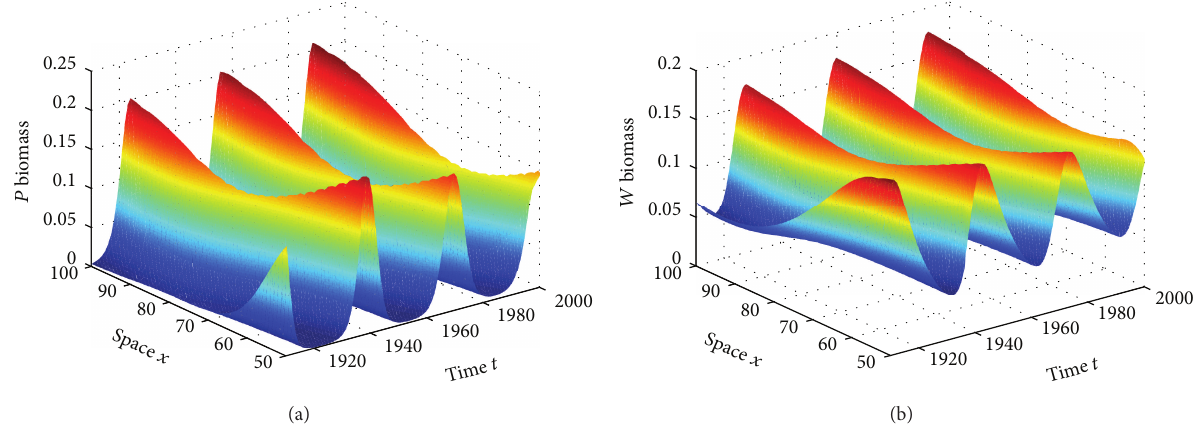
Figure 3: Illustration of the existence of spatially nonhomogeneous periodic solutions of system (2) for 𝑠 = 0 . 15, 𝑏 = 0 . 08, 𝑎 = 10, 𝑘 = 0 . 2, = 1 . 05, and 𝑑 = 0 . 7 and initial conditions (𝑃 𝑑 1 2